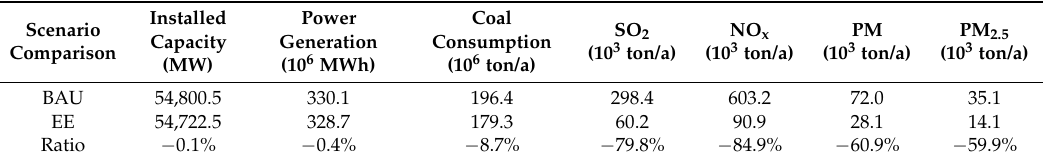
Table 4. Scenario